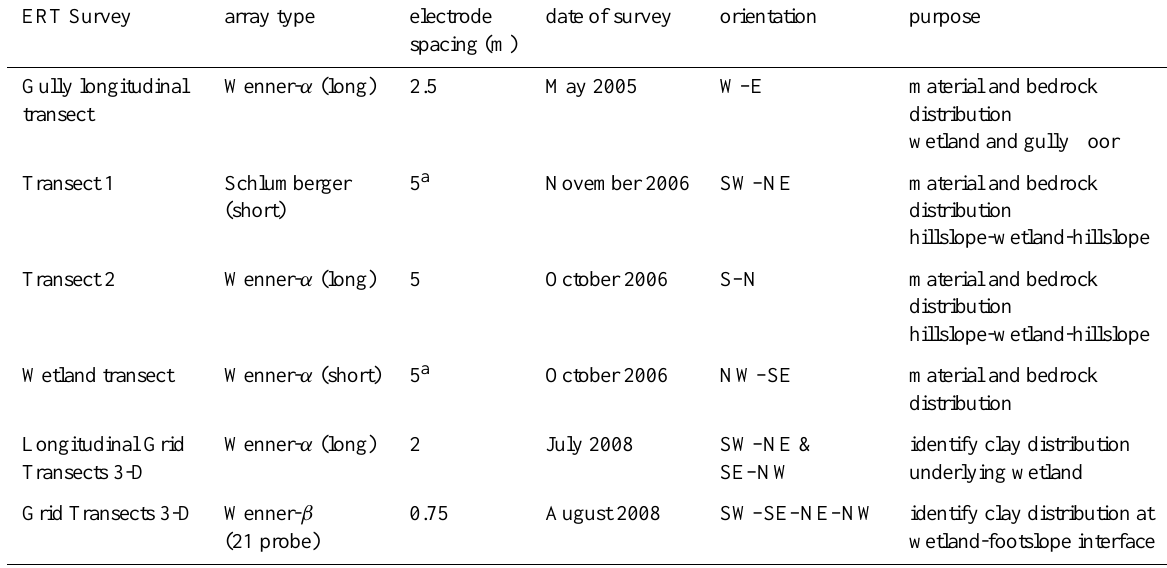
Table 2. 2-D ERI surveys timing and arrays deployed in the Manalana